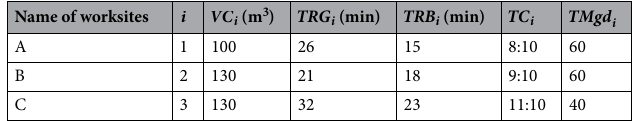
Table 2. Corresponding calculation parameters of each